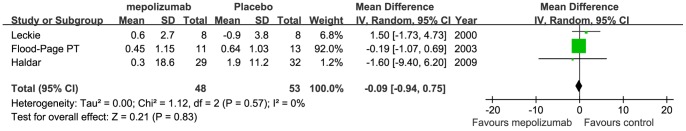
The effects of mepolizumab on histamine PC20 (mg/ml).